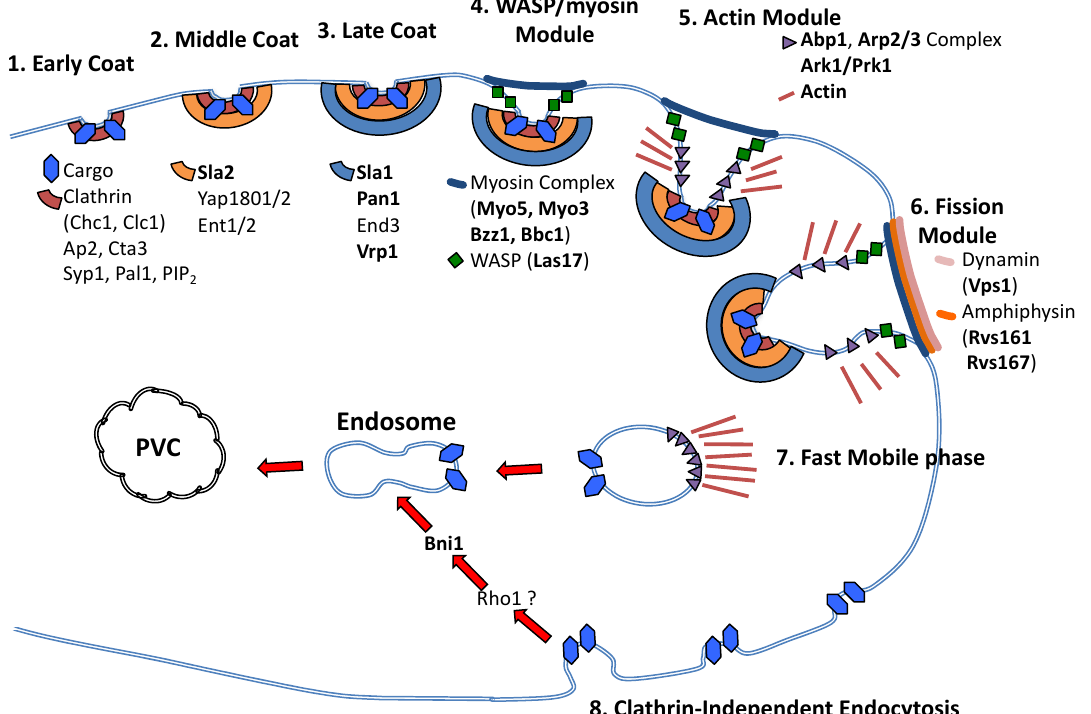
Figure 3. Clathrin-mediated and clathrin-independent endocytosis in yeast. Clathrin-mediated endocytosis is a highlyorchestrated, step-wise process that begins at the plasma membrane and leads to delivery of endocytic cargo through the endosomal pathway to the PVC (pre-vacuolar compartment). The clathrin-independent has fewer identified proteins but also leads through the endosomal pathway to the PVC. Proteins shown in bold have been studied in C. albicans , others are orthologous to ones studied in S. cerevisiae . Little is known about the role of clathrin-independent endocytosis in C. albicans .